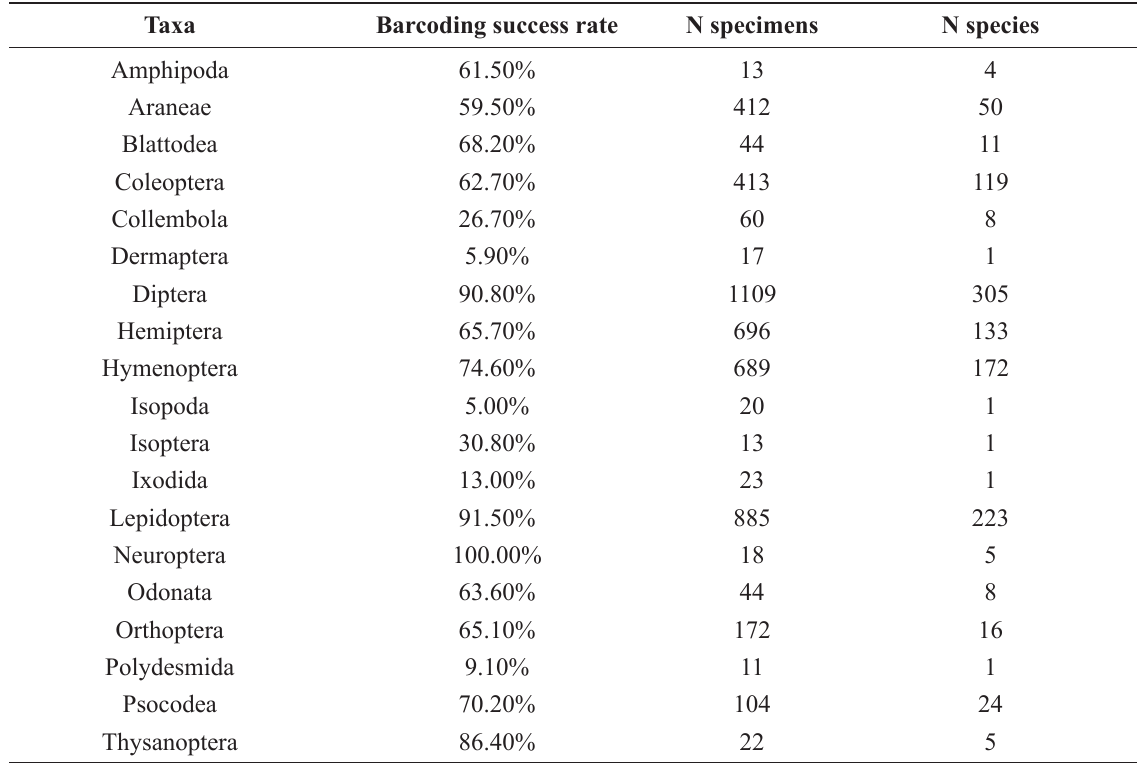
Table 2. Rate of DNA barcoding success in the main taxa under study. Groups with fewer than 10 specimens tested are not included. The barcoding success rate is defined as the proportion of specimens tested that yielded a quality DNA barcode (see Material and methods for quality